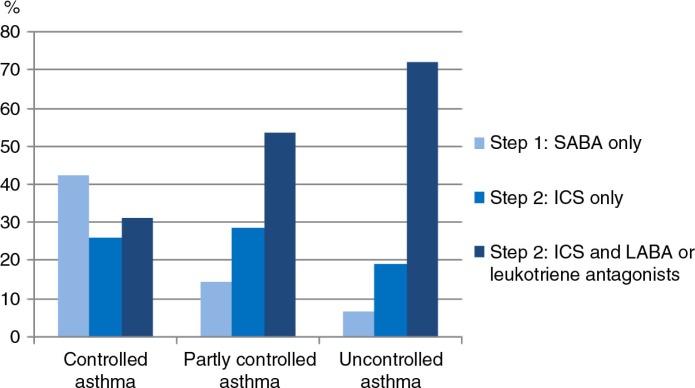
Asthma treatment steps. Step 1: only SABA on-demand. Step 2: ICS alone for maintenance and SABA on-demand. Step 3: ICS and LABA or leukotriene antagonists for maintenance and SABA on-demand.